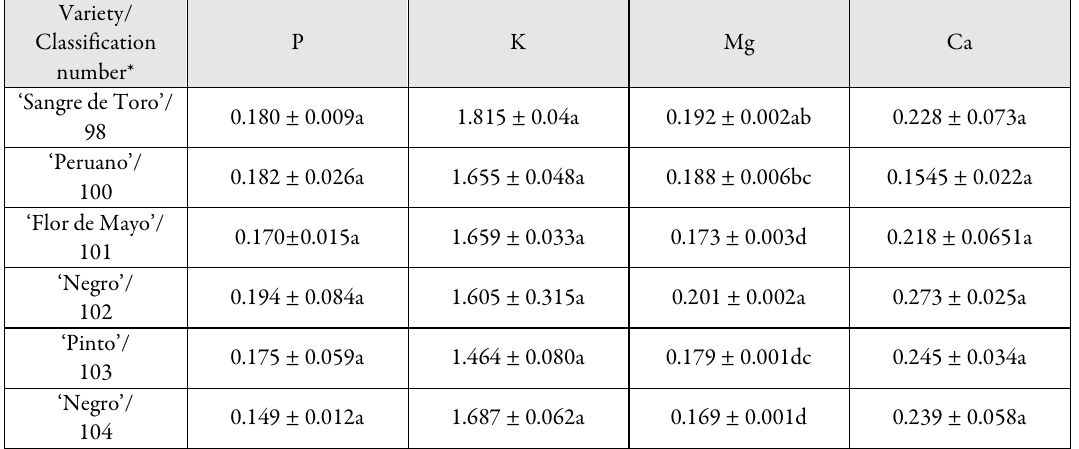
Data correspond to mean ± SD. Different letters per column indicate significant statistical difference between varieties. Tukey test (p ≤ 0.05). *Laboratory work